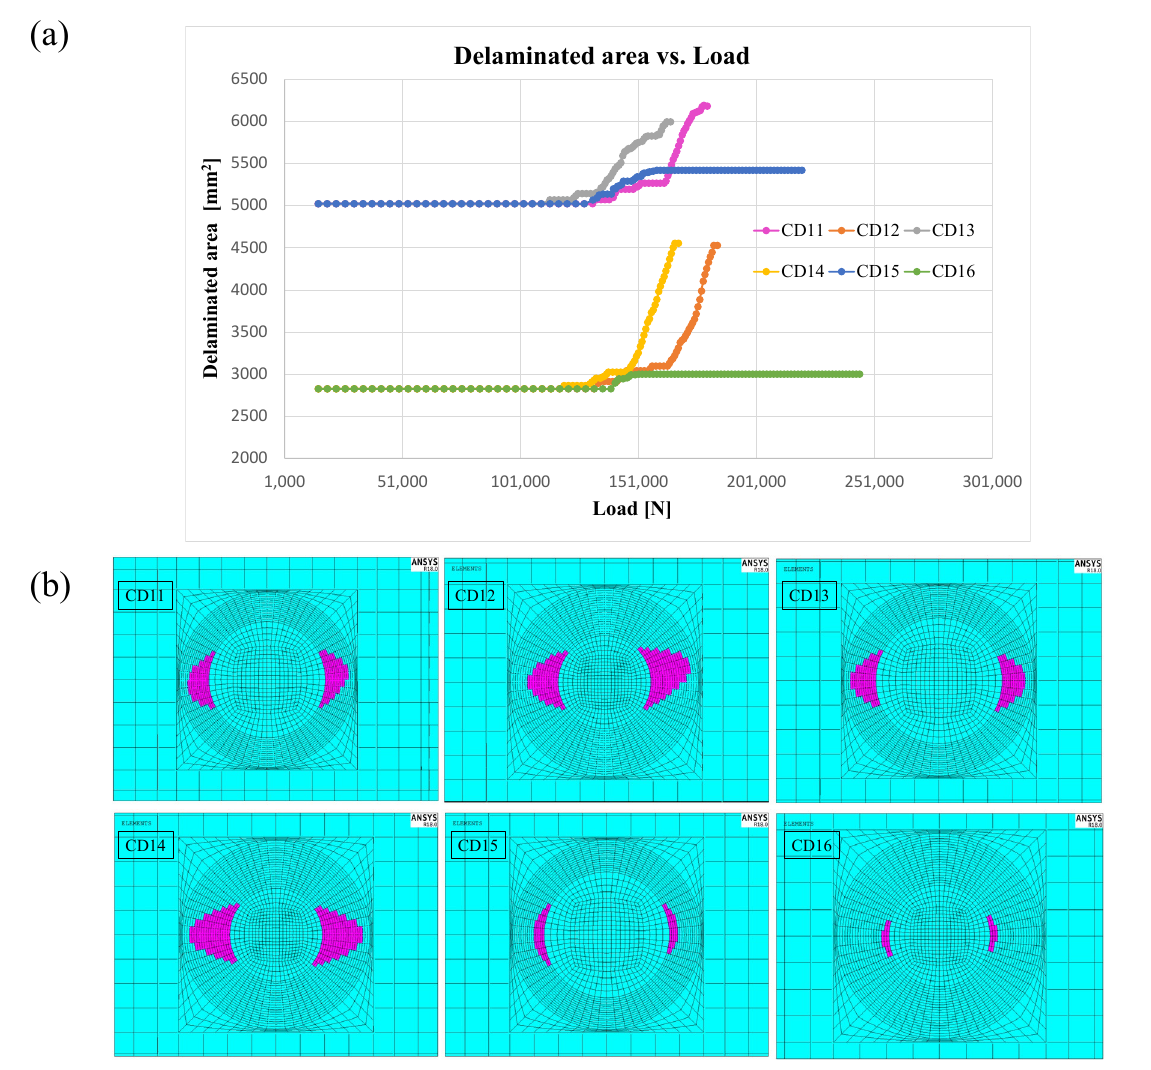
Figure 12. CD11– CD16 configurations: ( a ) delaminated area vs. load curves; ( b ) delamination evolution at final analyses load (pink represent the delaminated area) .